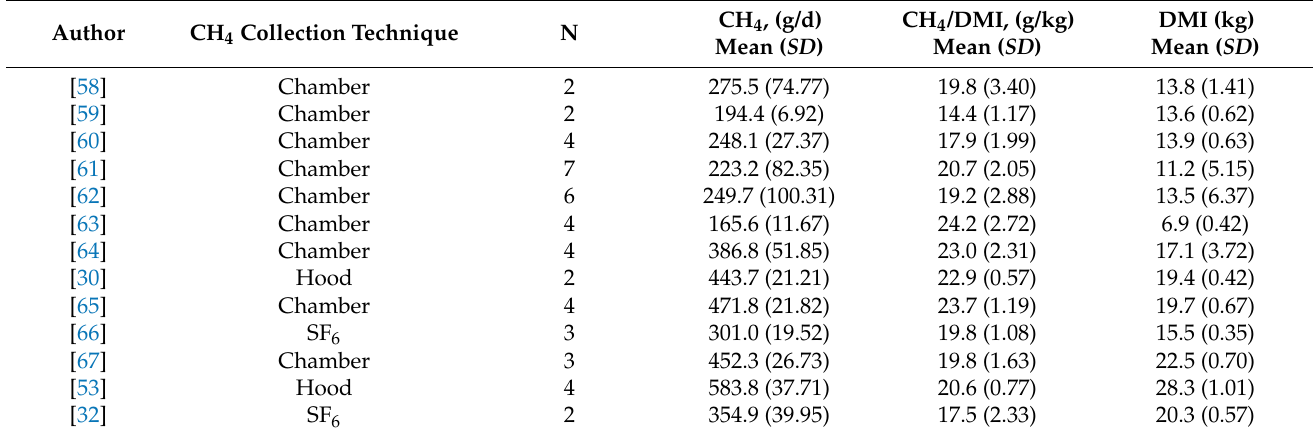
Table 1. Summary of the database used for the model